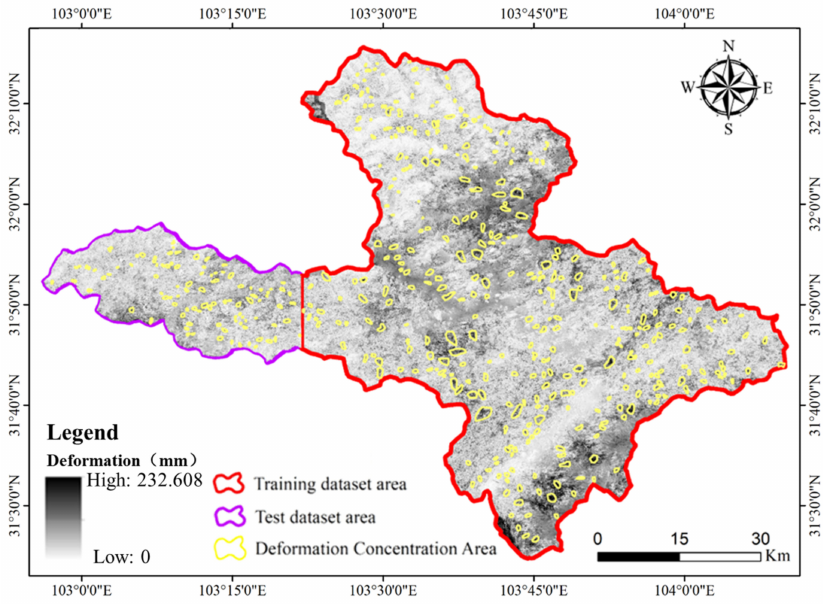
deformation area shall not exceed 5 mm. (2) The difference between internal and external deformation at the boundary of anomalous deformation area is greater than 5 mm. (3) The anomalous deformation area is a closed polygon, and the number of internal grids is not less than 16. The distributions of the 316 training samples and 103 test samples are shown in Figure 16.